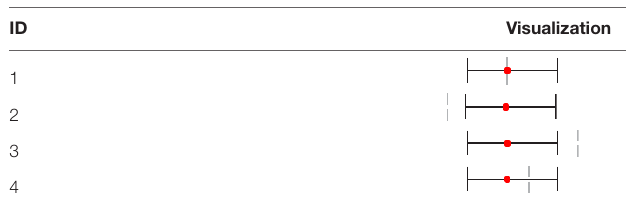
TABLE 2 | Exemplary visualization of the statistical